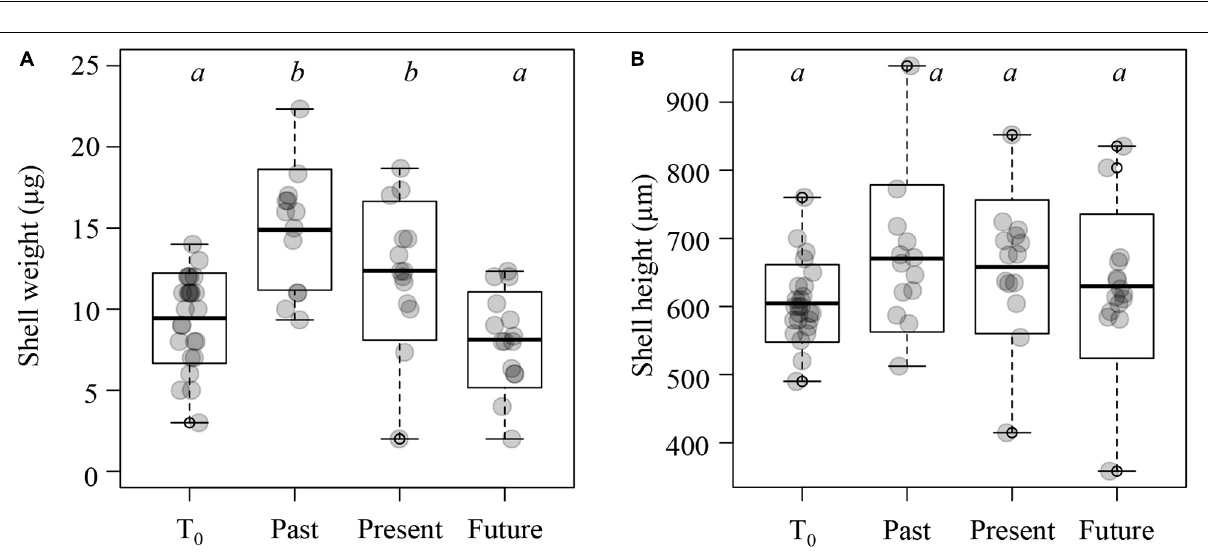
FIGURE 5 | Shell weight and height of Limacina retroversa at T 0 (25 individuals), and after exposure to past, present, and near-future conditions (13–15 individuals per treatment). (A) Shell weight. (B) Shell height. Horizontal line within the boxplots represents the mean, the boxes the standard deviation, and bars the minimum and maximum values; scattered dots represent all individual measurements. Boxplots with different letters denote significant differences between treatments (see main text for